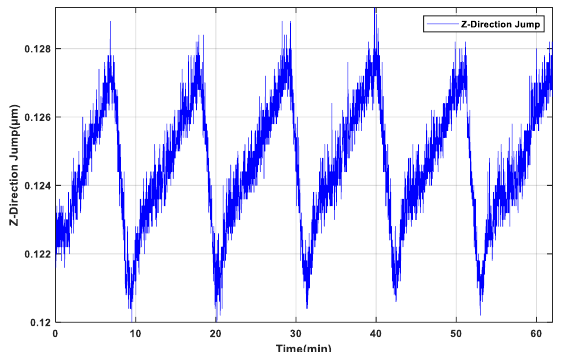
Figure 13. Time-domain vibration measurement results in the vertical direction.